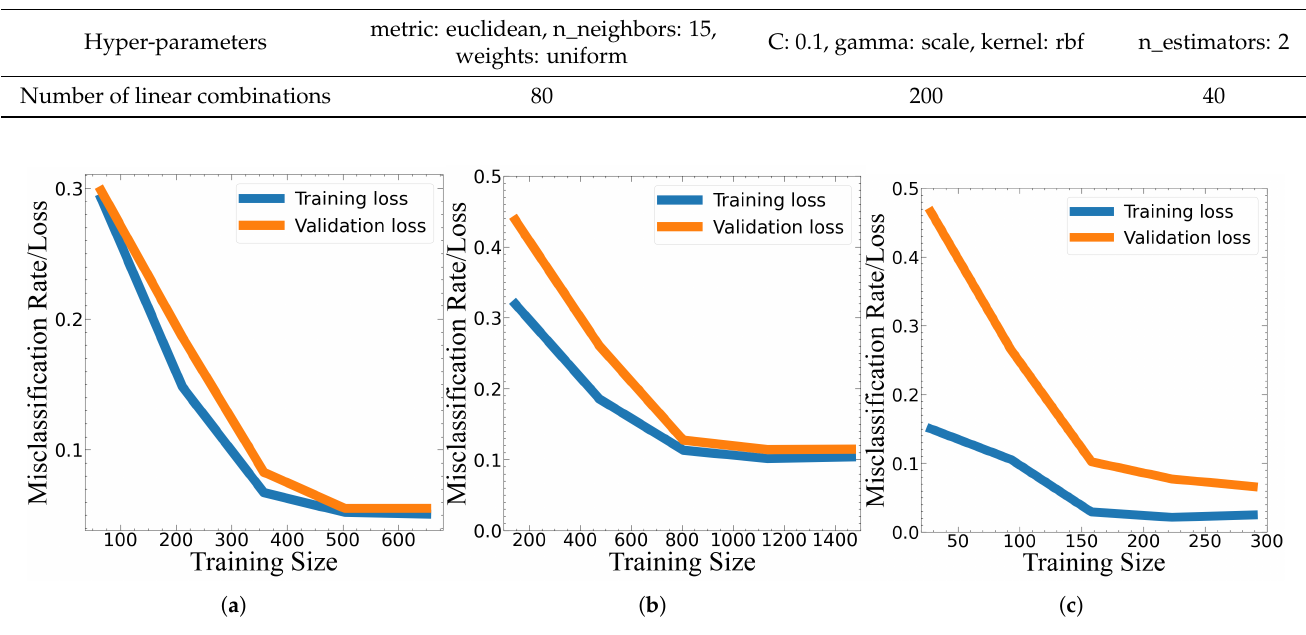
Figure 7. Learning curves for the ( a ) KNN, ( b ) SVM and ( c ) GB